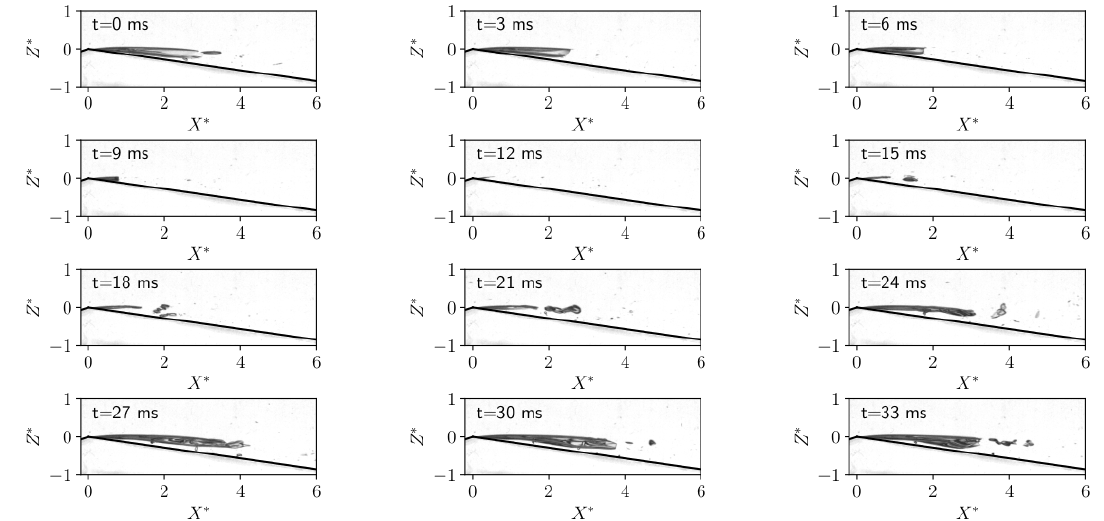
Figure 8. One cycle viewed from side in the type-2 periodic shrinking regime ( (cid:4) ) at Re = 1614, σ 1 = 4.87 and σ 2 = 0.92. The measured frequency of the cycle is 34.6 Hz